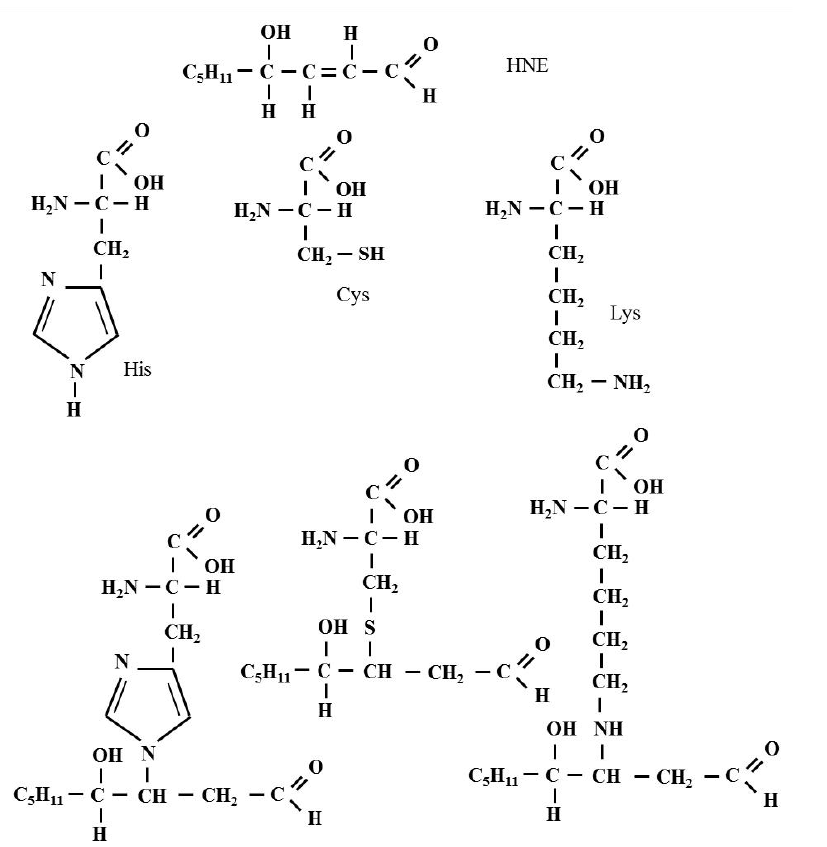
Figure 3. The formation of the Michael adduct in the reaction of HNE with Cys, His and Lys residues present in the polypeptide chain. As a result of this reaction, chemical bonds are formed, including a single carbon-sulfur bond and a single carbon-nitrogen bond.